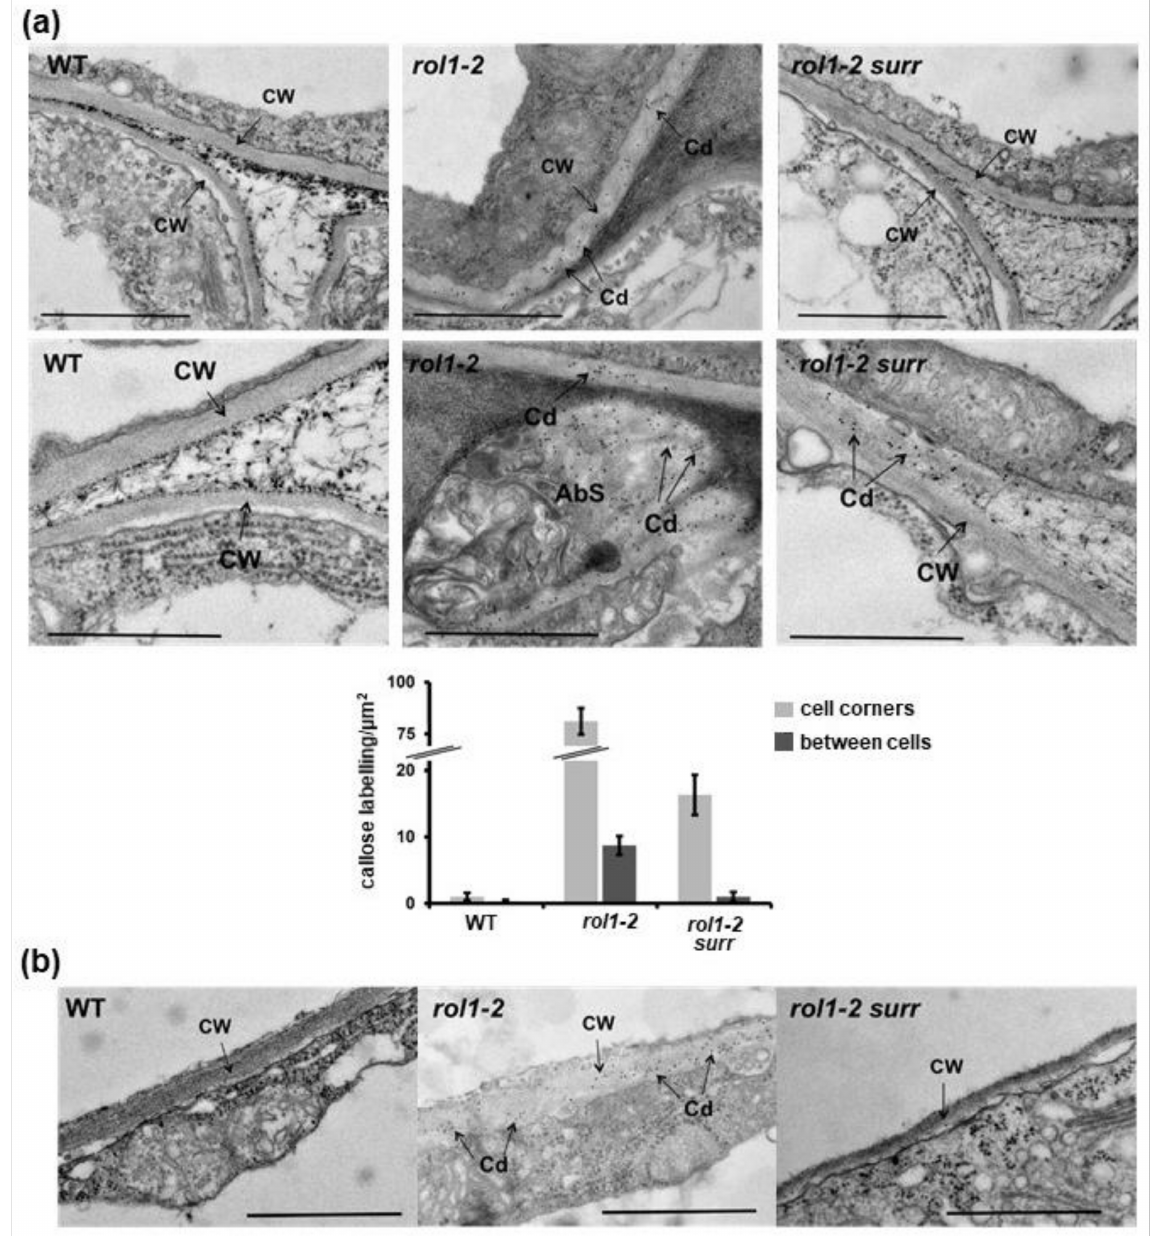
Figure 3. Ectopic callose deposition in cell walls of the rol1-2 mutant. ( a ) In root tissue, detection of callose revealed no labelling in the wild type (left column, lower picture with stronger magnification), strong labelling in rol1-2 (middle column) with occurrence of callose deposits (lower picture), and rare labelling in rol1-2 surr mutant roots (no and weak labelling in upper and lower picture, respectively). cw: cell wall; cd: callose deposition; AbS: abnormal structures rich in callose. Quantification of callose labelling between the genotypes for cell walls in cell corners and cell walls between neighboring cells. (All differences between genotypes are significant; student t -test; p < 0.05; n > 10). Error bars represent standard error of the mean. Bar = 1 µ m.( b ) In contrast to wild-type root hairs that develop compact cell walls (left), cell walls of rol1-2 root hairs are rich in callose and have an overall altered, low-electron density appearance (middle). This effect of rol1-2 is suppressed in the rol1-2 surr mutant (right). cw: cell wall; Cd: callose. Bar = 1 µ